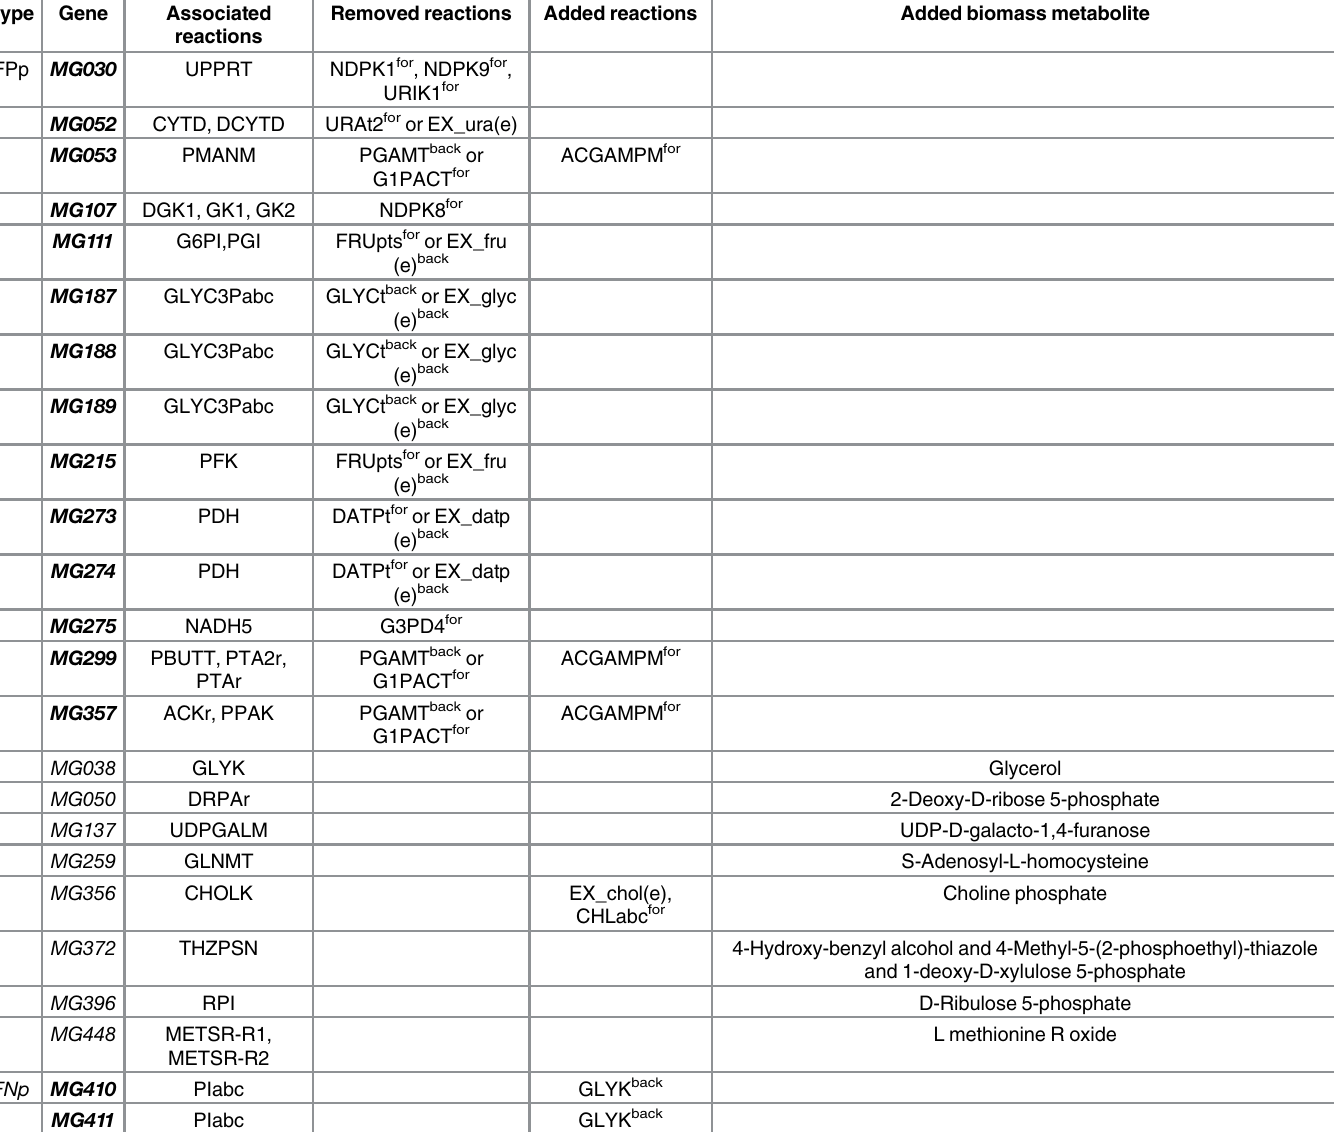
Table 2. Modifications of the M . genitalium network suggested by GlobalFit based on 187 gene knockout experiments (bold font indicates conser- vative changes). Type